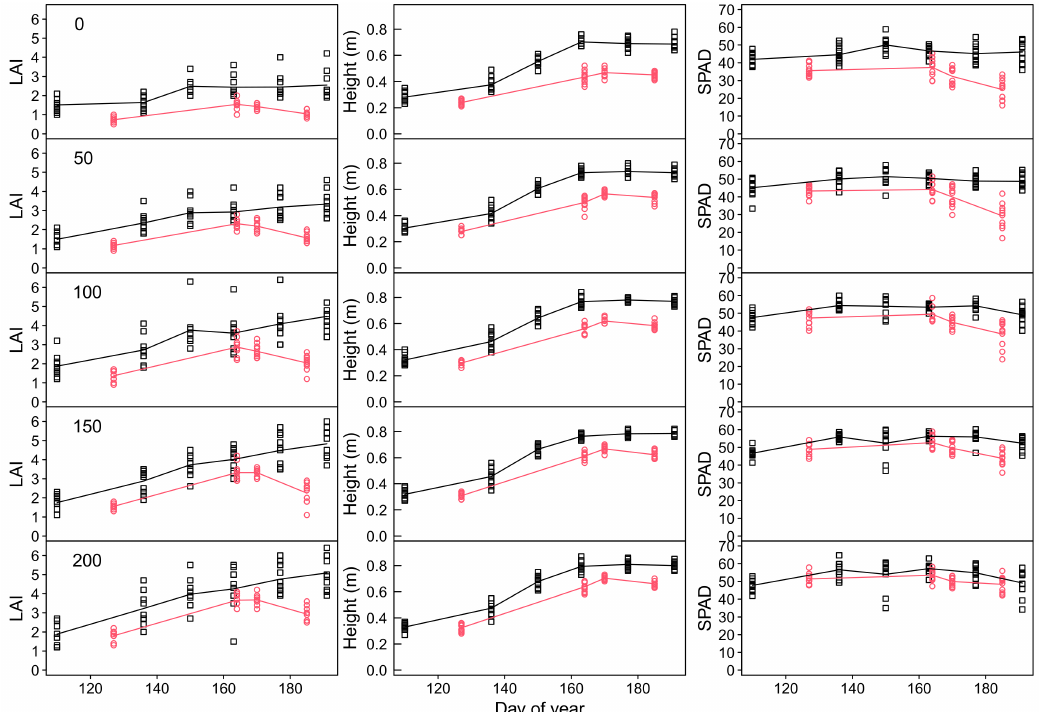
Figure 3. Variation in leaf area index (LAI, Left panels ), height ( Centre panels ) and SPAD (a measure of leaf chlorophyll, Right panels ) over two years (2017, black; 2018, red) under five different fertiliser treatments (rows, from 0–200 kg N ha − 1 ). Points show individual trials plots ( n = 10 per time period) and lines connect the mean values of the trials at each time period. Day of year 1 = 1st